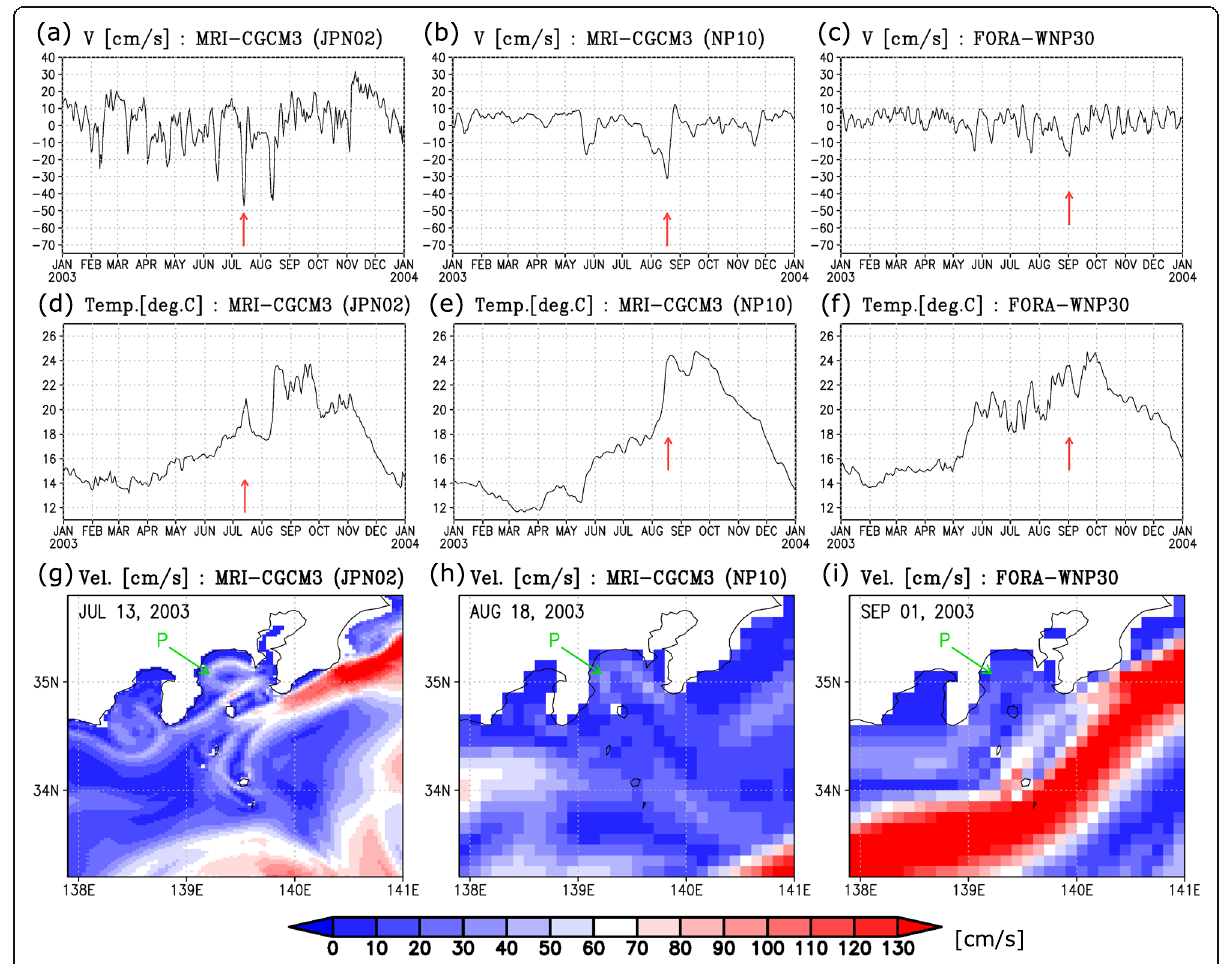
Fig. 15 Time series of the daily mean a – c meridional velocity (cm s − 1 ) and d – f temperature (°C) at 27 m depth in 2003 at point P (139.21° E, 35.09° N) near the western coast of Sagami Bay (denoted in g – h ). g – h Surface velocity (cm s − 1 ) maps (at 27 m depth) on g July 13, 2003; h August 18, 2003; and i September 1, 2003, denoted by the red arrows in each upper panel ( a – f ). a , d , g Denoting the JPN02 results of MRI- CGCM3. b , e , h Denoting the NP10 results of MRI-CGCM3. c , f , i Drawn from the FORA-WNP30 data